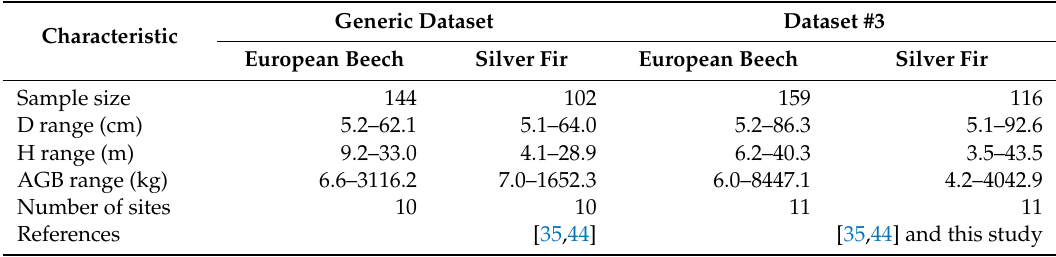
Table 3. The characteristics of the generic biomass sample and Dataset